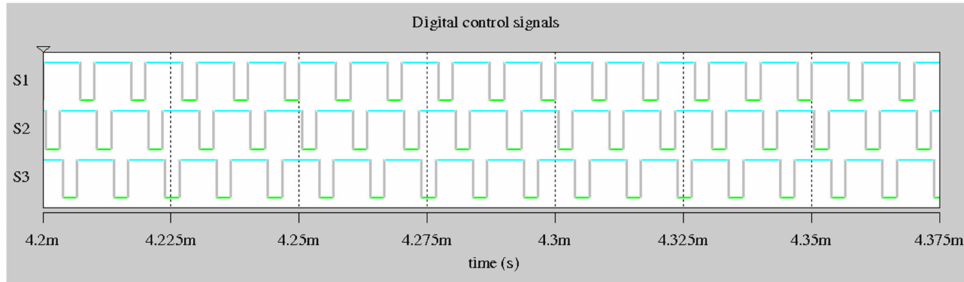
Figure 4. Simulation results for digital control signal S1 , S2 , S3 with ϕ = 120 ◦ and d = 0.72.